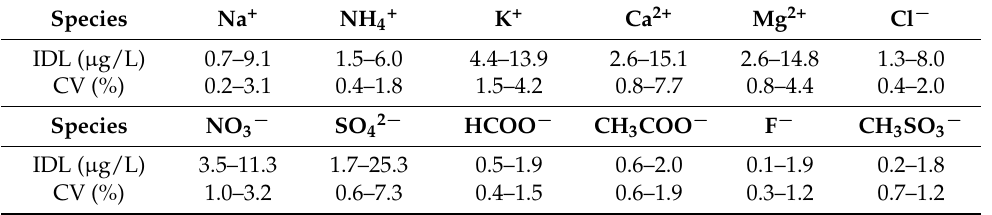
Table 1. Instrument detection limit (IDL) and coefficient of variation (CV) for the ionic components (n =